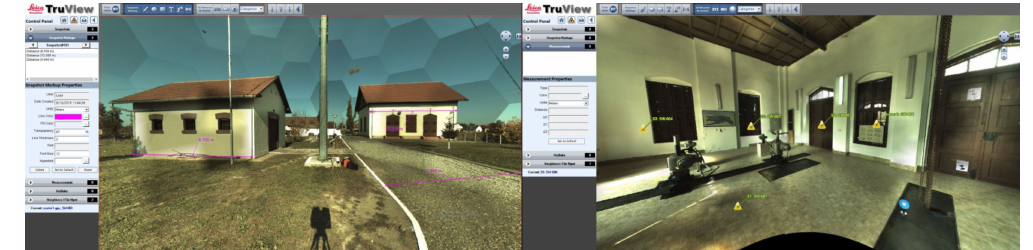
Figure 20. TruView link for NH Cos